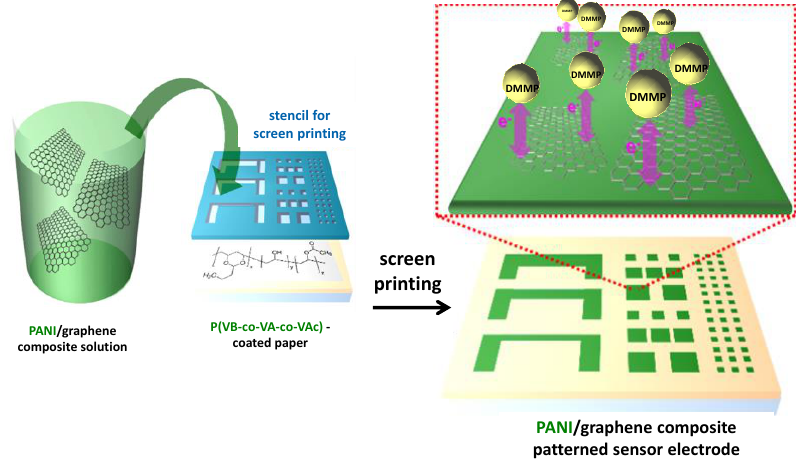
Figure 1. Fabrication process of conductive paper containing sensor patterns for dimethyl methylphosphonate (DMMP) based on poly(aniline) (PANI)/graphene composite. Reproduced and adapted with permission of American Chemical Society [15].